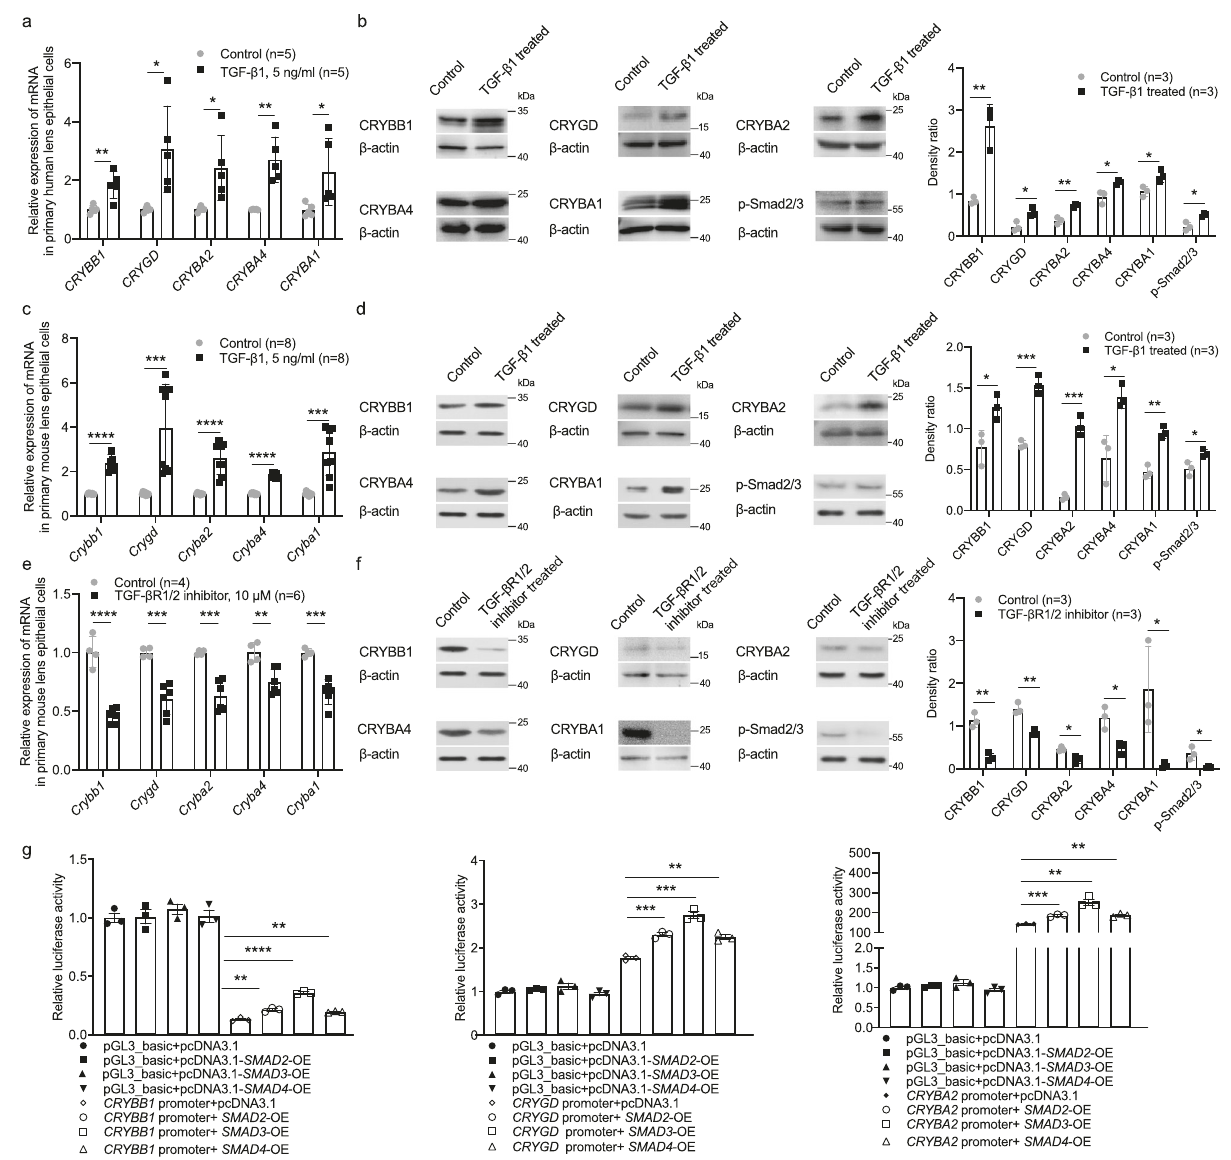
Fig. 7 Up-regulation of β / γ -crystallins by TGF- β 1. a , b Changes of β / γ -crystallin gene expression detected by qPCR ( n = 5, CRYBB1 p = 0.005, CRYGD p = 0.015, CRYBA2 p = 0.022, CRYBA4 p = 0.001, CRYBA1 p = 0.036) and Western blotting ( n = 3, CRYBB1 p = 0.004, CRYGD p = 0.021, CRYBA2 p = 0.003, CRYBA4 p = 0.022, CRYBA1 p = 0.027) and changes of p-Smad2/3 level detected by Western blotting ( n = 3, p = 0.013) in primary human LECs from emmetropic eyes after TGF- β 1 treatment (5 ng/ml for 24 h). Right, the band density in Western blotting was normalized to loading control as a ratio for statistical analysis. c , d Changes of β / γ -crystallin gene expression detected by qPCR ( n = 8, Crybb1 p = 4.65e − 8, Crygd p = 0.0009, Cryba2 p = 2.53e-5, Cryba4 p = 3.58e-11, Cryba1 p = 0.0002) and Western blotting ( n = 3, CRYBB1 p = 0.029, CRYGD p = 0.0005, CRYBA2 p = 0.0003, CRYBA4 p = 0.015, CRYBA1 p = 0.001) and changes of p-Smad2/3 level detected by Western blotting ( n = 3, p = 0.027) in primary cultured mouse LECs with TGF- β 1 treatment (5 ng/ml for 24 h). Right, the band density in Western blotting was normalized to loading control as a ratio for statistical analysis. e , f Changes of β / γ -crystallin gene expression detected by qPCR ( n = 4 in control and 6 in the treated group, Crybb1 p = 2.05e-5, Crygd p = 0.0004, Cryba2 p = 0.0005, Cryba4 p = 0.004, Cryba1 p = 0.0003) and Western blotting ( n = 3, CRYBB1 p = 0.002, CRYGD p = 0.003, CRYBA2 p = 0.015, CRYBA4 p = 0.016, CRYBA1 p = 0.038) and changes of p-Smad2/3 level detected by Western blotting ( n = 3, p = 0.021) in primary cultured mouse LECs with TGF- β R1/2 inhibitor treatment (LY2109761, 10 μ M for 24 h). Right, the band density in Western blotting was normalized to loading control as a ratio for statistical analysis. g Elevated transcriptional activity of crystallin genes with co-transfection of SMAD s plasmid ( n = 3; CRYBB1 promoter: SMAD2 p = 0.004, SMAD3 p = 6.36e-5, SMAD4 p = 0.004; CRYGD promoter: SMAD2 p = 0.0007, SMAD3 p = 0.0003, SMAD4 p = 0.002; CRYBA2 promoter: SMAD2 p = 0.0008, SMAD3 p = 0.002, SMAD4 p = 0.001). n = biological replicates. Results are expressed as mean ± SD. Level of signi fi cance was detected by two-sided Student ’ s t test ( a – g ). **** p < 0.0001, *** p < 0.001, ** p < 0.01 and * p < 0.05. Source data are provided as a Source Data fi le.